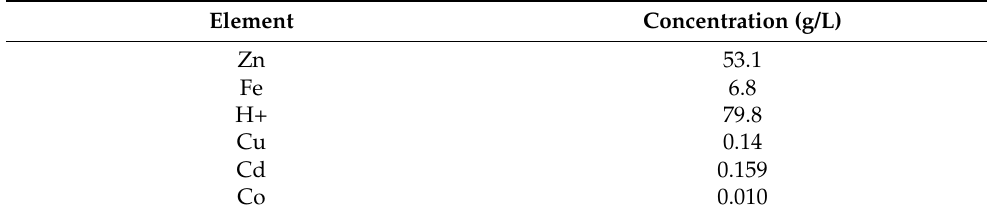
Table 3. Characterization of the leach solution